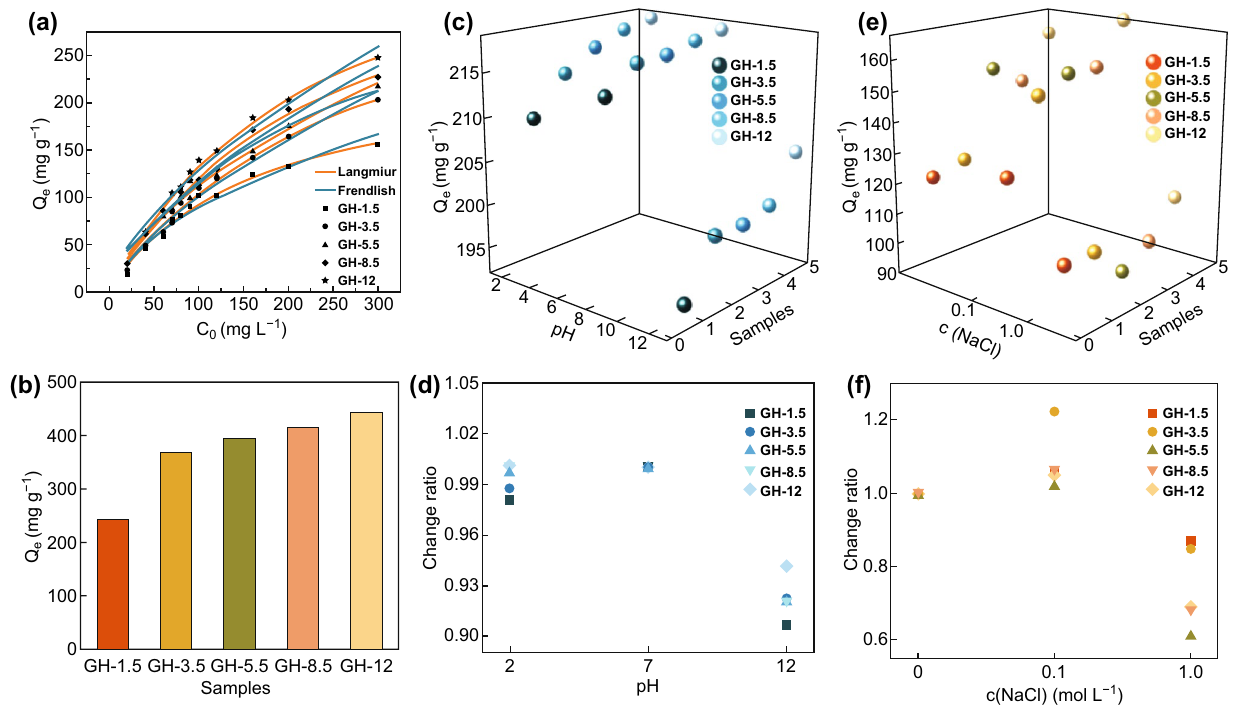
Fig. 6 a Equilibrium adsorption isotherms for the GH samples, b maximum adsorption capacity of the GH samples calculated by Langmuir iso- therms, c adsorption capacity, and d change ratio of the adsorption capacity for the GH samples under different c (NaCl) conditions. e Adsorption capacity and f change ratio of the adsorption capacity of the GH samples prepared at different pH